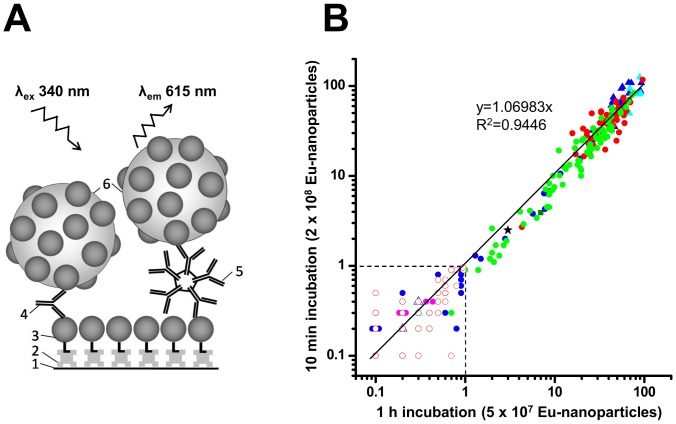
Design and evaluation of the in-house TRF immunoassays.(A) Schematic representation of the in-house TRF immunoassay. The design of both the TRF immunoassays was same, except for different incubation times and tracer amounts. The numbers represent the following: (1) microtiter well surface, (2) streptavidin, (3) r-Bio-p15-17-47, (4) serum anti-Tp IgG antibody, (5) serum anti-Tp IgM antibody, and (6) r-p15-17-47 coated on Eu3+ chelate-doped nanoparticles. (B) Scatter plot with the S/Co values of all serum samples (n = 311) analyzed in this study, using the in-house TRF immunoassays with 1 h (x axis) and 10 min (y axis) incubation times. Different symbols represent positive (+) or negative (-) serum samples, either from commercial panels based on the results provided by the panel supplier, or from six different categories (#1 – #6) of the in-house samples based on their reactivities with the reference assays as described in Table 1. Symbols for different kind of samples are as the following: PSS202 (+), filled blue triangles; PSS202 (-), empty blue triangles; QSS701 (+), filled cyan triangles; QSS701 (-), empty cyan triangle; samples of category #1, filled red circles; samples of category #2, filled green circles; samples of category #3, filled blue circles; samples of category #4, filled magenta circles; sample of category #5, filled olive square; samples of category #6 (except one sample), empty red circles; and exceptional sample of category #6 which gave positive results with in-house TRF immunoassays, black star. Dashed vertical and horizontal lines represent the cutoffs (at S/Co = 1) for the two TRF immunoassays.